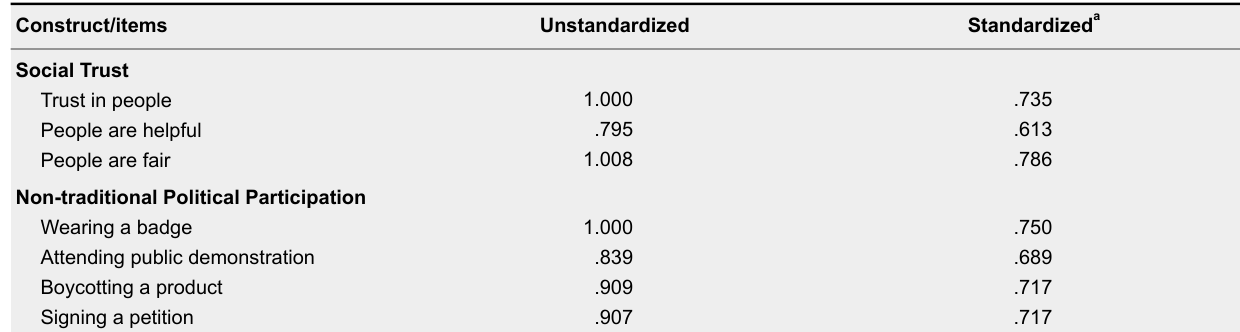
Standardized a UnstandardizedConstruct/items